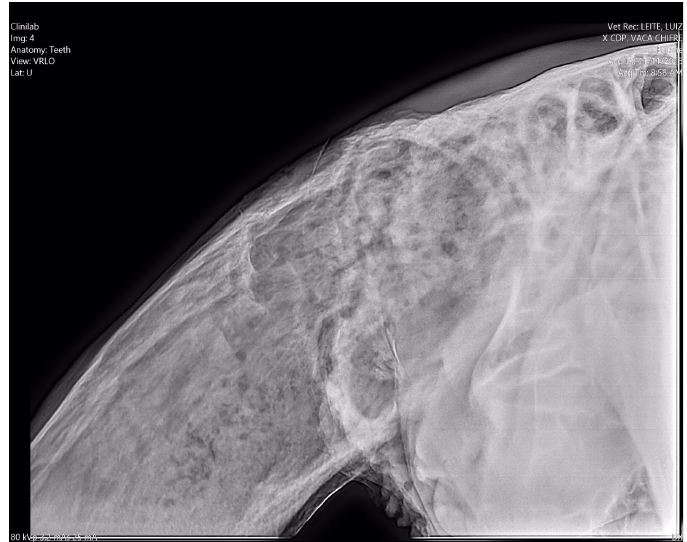
Figura 2. Radiografia do corno esquerdo evidenciando o seu preenchimento por massa